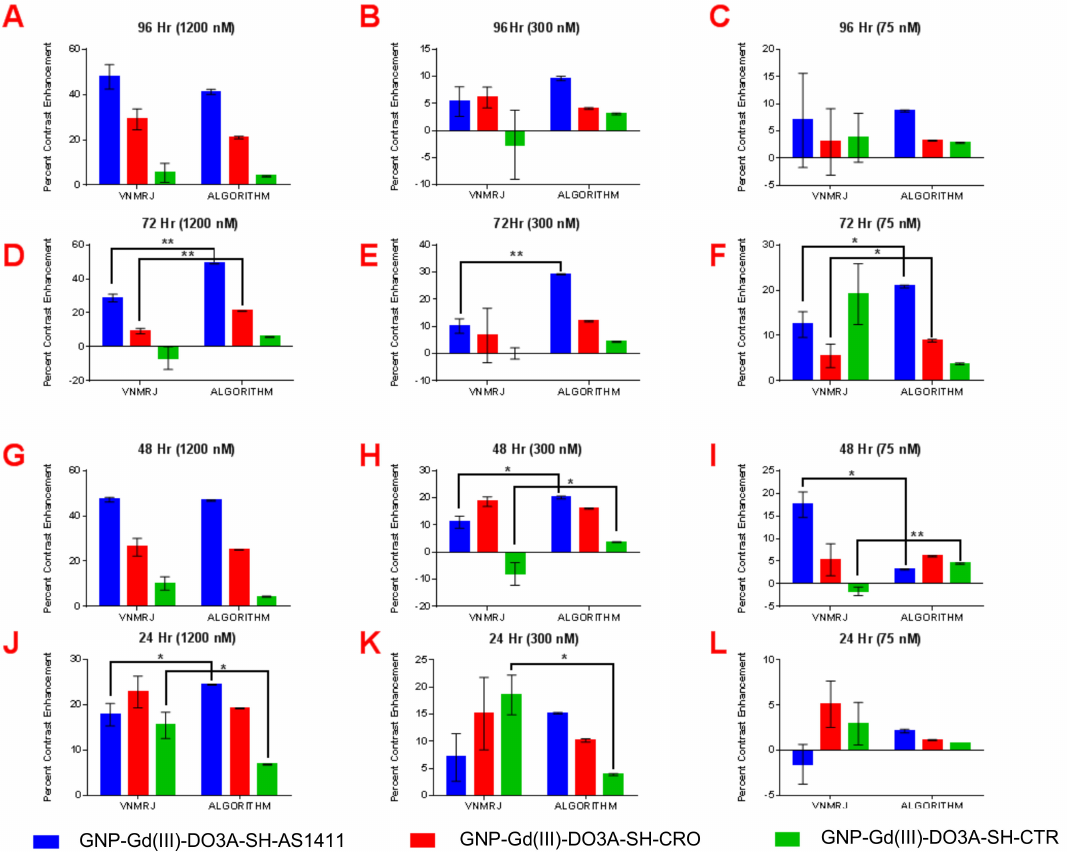
Figure 6. Paired t -test analysis of percent contrast enhancement: VNMRJ vs. algorithm in MDA-MB-231 cell lines using region of interest analysis ( n = 3) at the following time points / GNP-Gd(III)-DO3A-SH- Oligonucleotide concentrations; ( A ) 96 h / 1200 nM, ( B ) 96 h / 300 nM, ( C ) 96 h / 75 nM, ( D ) 72 h / 1200 nM, ( E ) 96 h / 300 nM, ( F ) 72 h / 75 nM, ( G ) 48 h / 1200 nM, ( H ) 48 h / 300 nM, ( I ) 48 h / 75 nM, ( J ) 24 h / 1200 nM, ( K ) 24 h / 300 nM, and ( L ) 24 h / 75 nM. Two-tail p -values (95% CI): * < 0.05; ** <